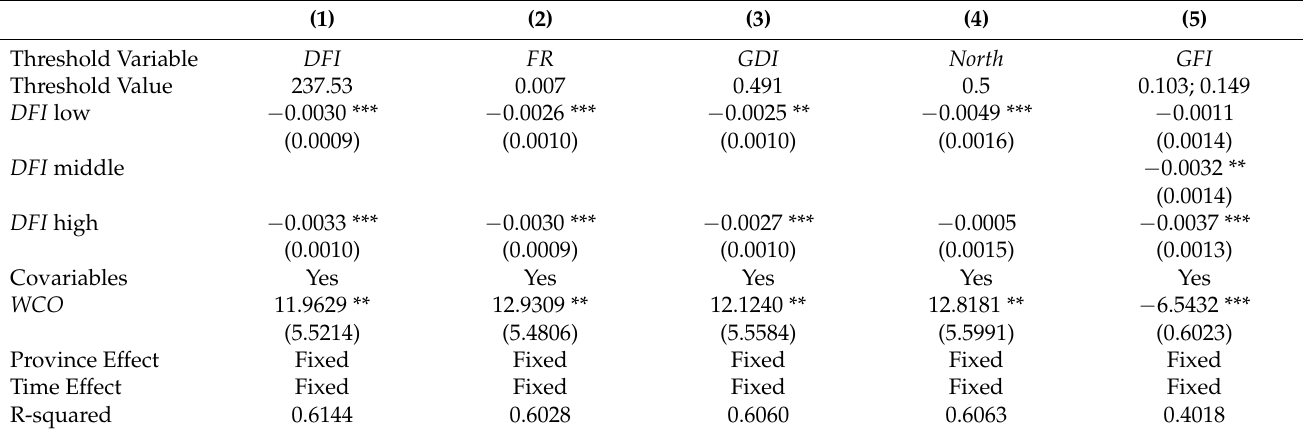
Table 9. Sub-threshold heterogeneity test of the effect of digital finance on CO 2